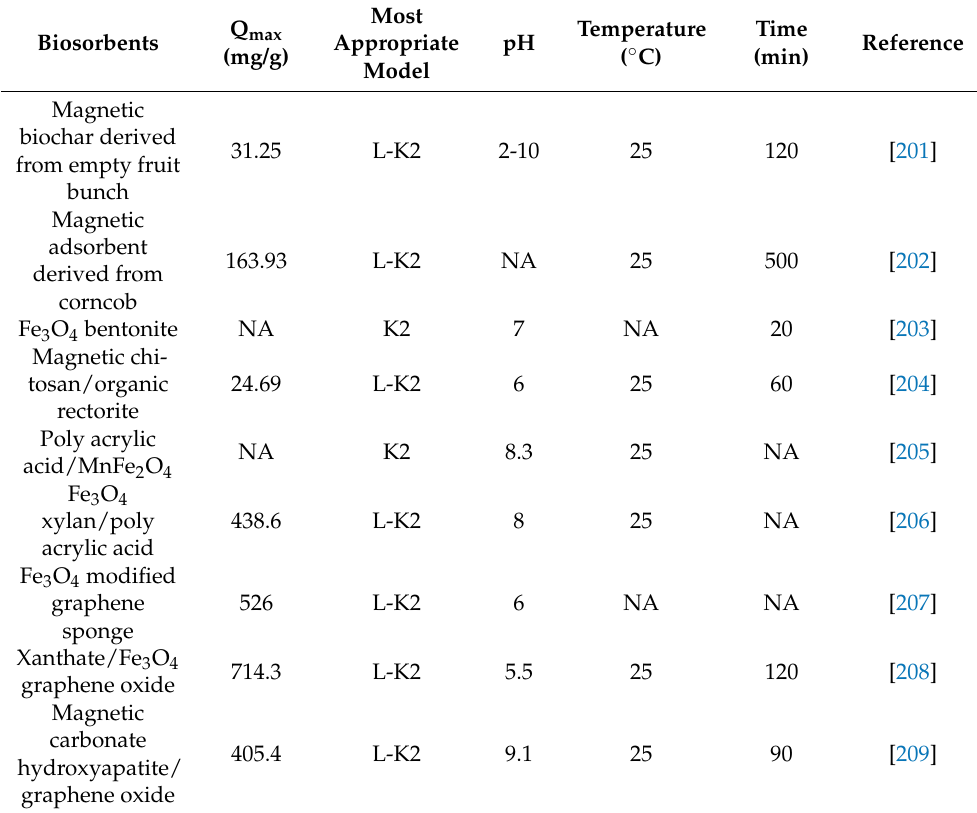
Table 7. Summary of bio-waste-derived adsorbent studies in 2015.